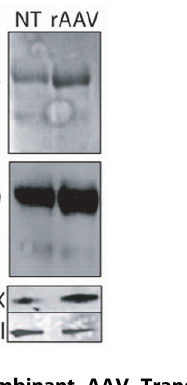
Figure 3. Recombinant AAV Transduction Activates a DNA Damage Response in hESCs. Total protein from scAAV3b- egfp transduced hESCs was harvested 8 h post-infection. Western blotting analysis was performed using the indicated antibodies.